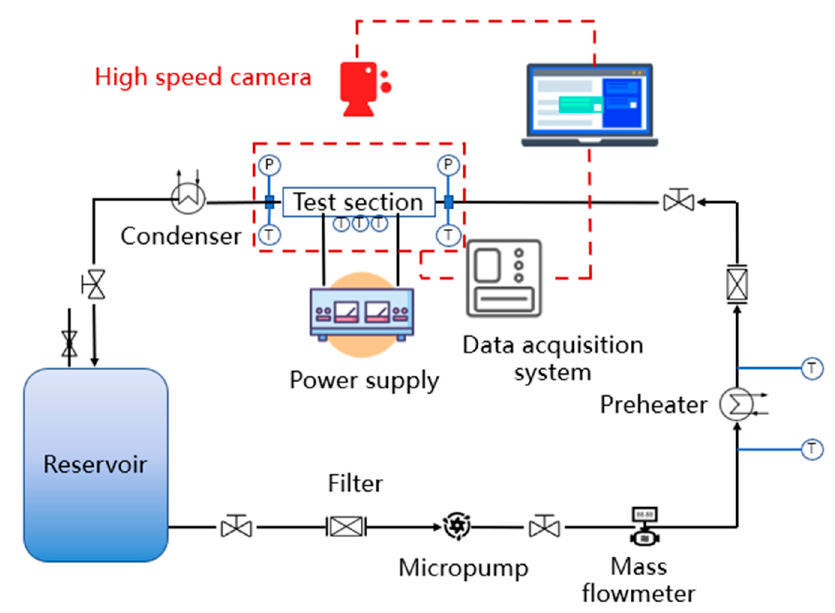
Figure 1. Experimental system schematic.